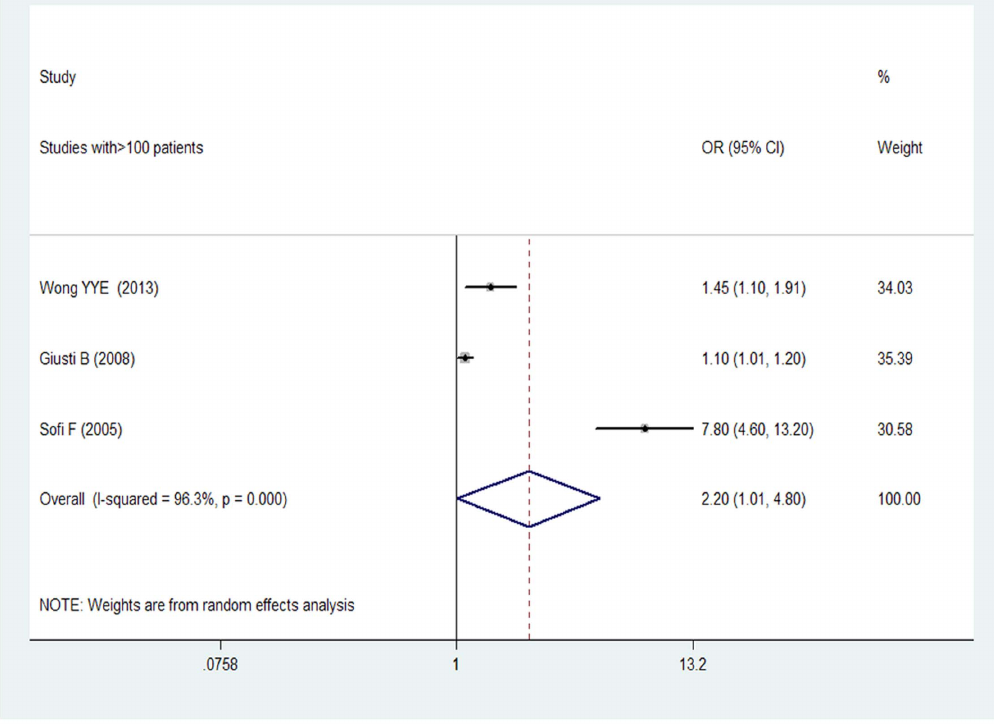
Figure 3. OR and 95% CI from the studies with . 100 patients of plasma Hcy level and AAA.